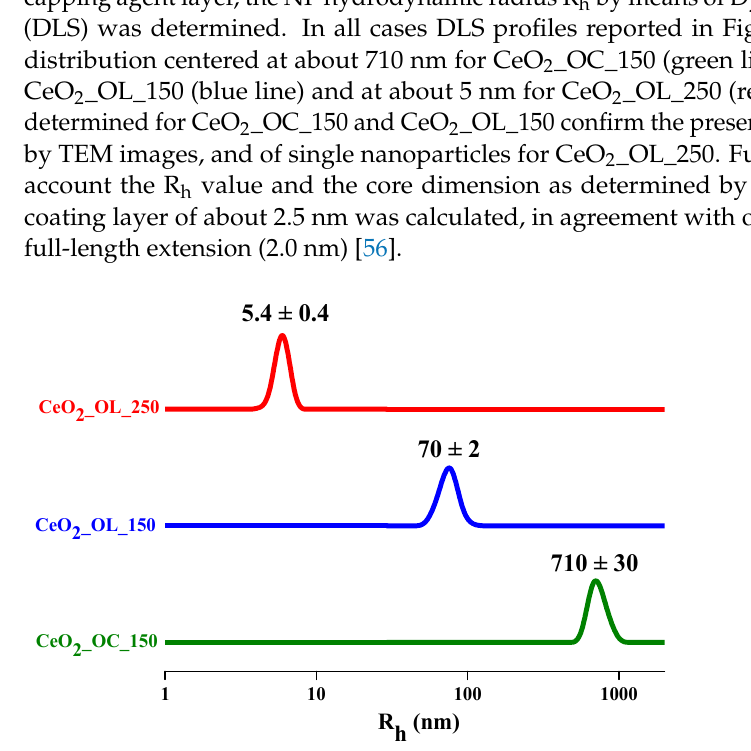
Figure 4. Hydrodynamic radius distribution of CeO 2 _OC_150 (green), CeO 2 _OL_150 (blue) and CeO 2 _OL_250 (red).